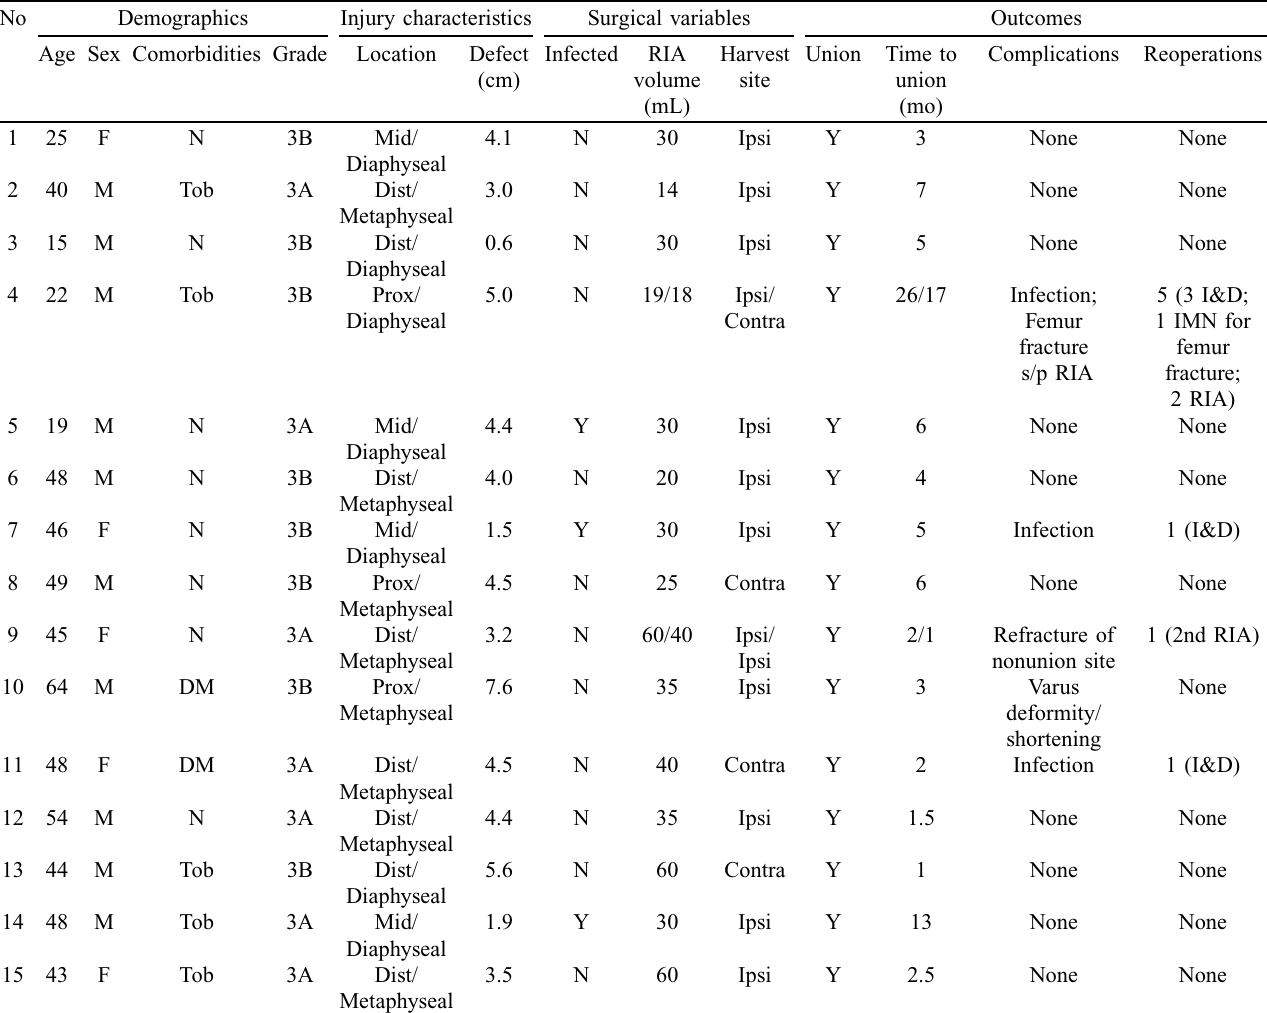
Table 1. Patient